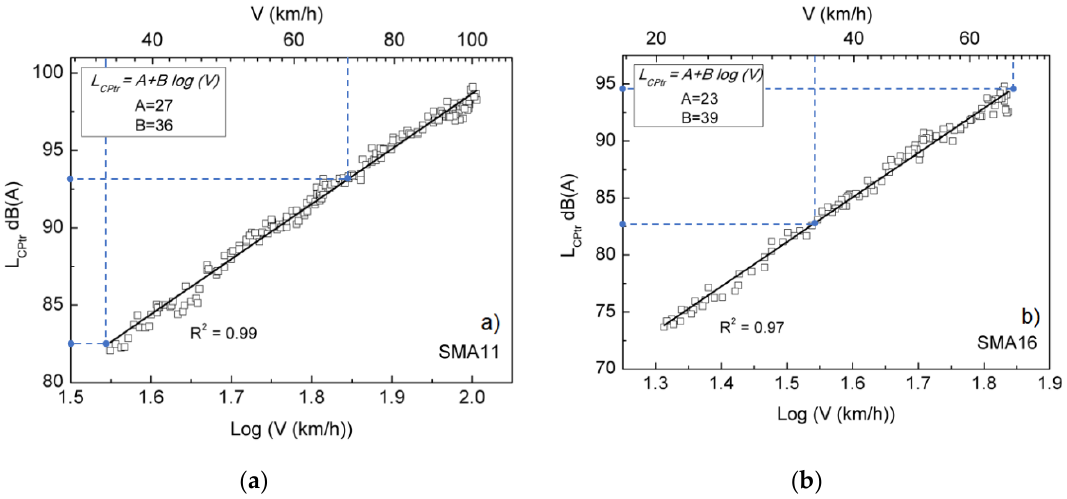
Figure 8. Linear regression of tire/pavement sound levels as a function of vehicle speed for the reference tire rolling on the bituminous mixtures SMA11 ( a ) and SMA16 ( b ).